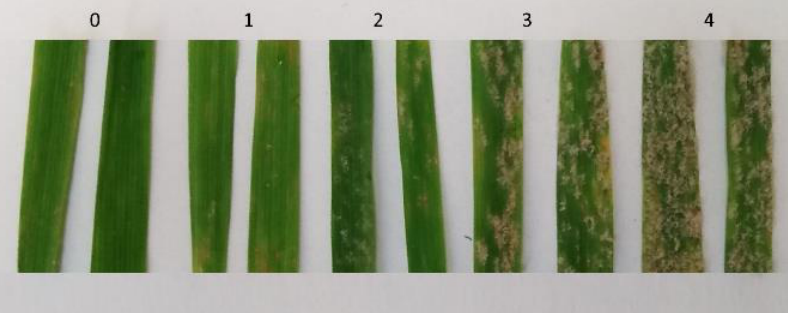
Figure 2. Photo of leaf fragments showing the different types of plant response to Bga infection.